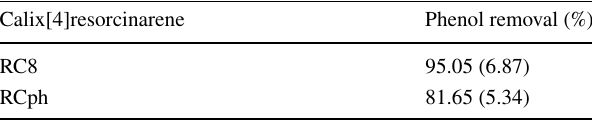
Table 1 Effect of Calix[4]resorcinarene nature on removal of phenol